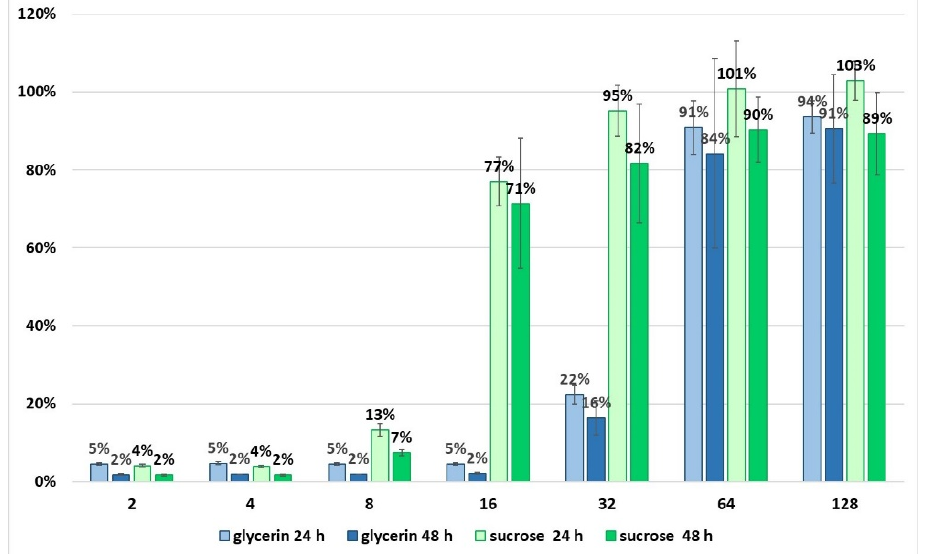
Figure 11. Viability of SC-1 R780 fibroblasts in the presence of glycerol or sucrose. The vertical axis denotes the percentage of viable cells, and the horizontal axis shows fold dilution of stock solutions of glycerol (75%) and sucrose (58%).